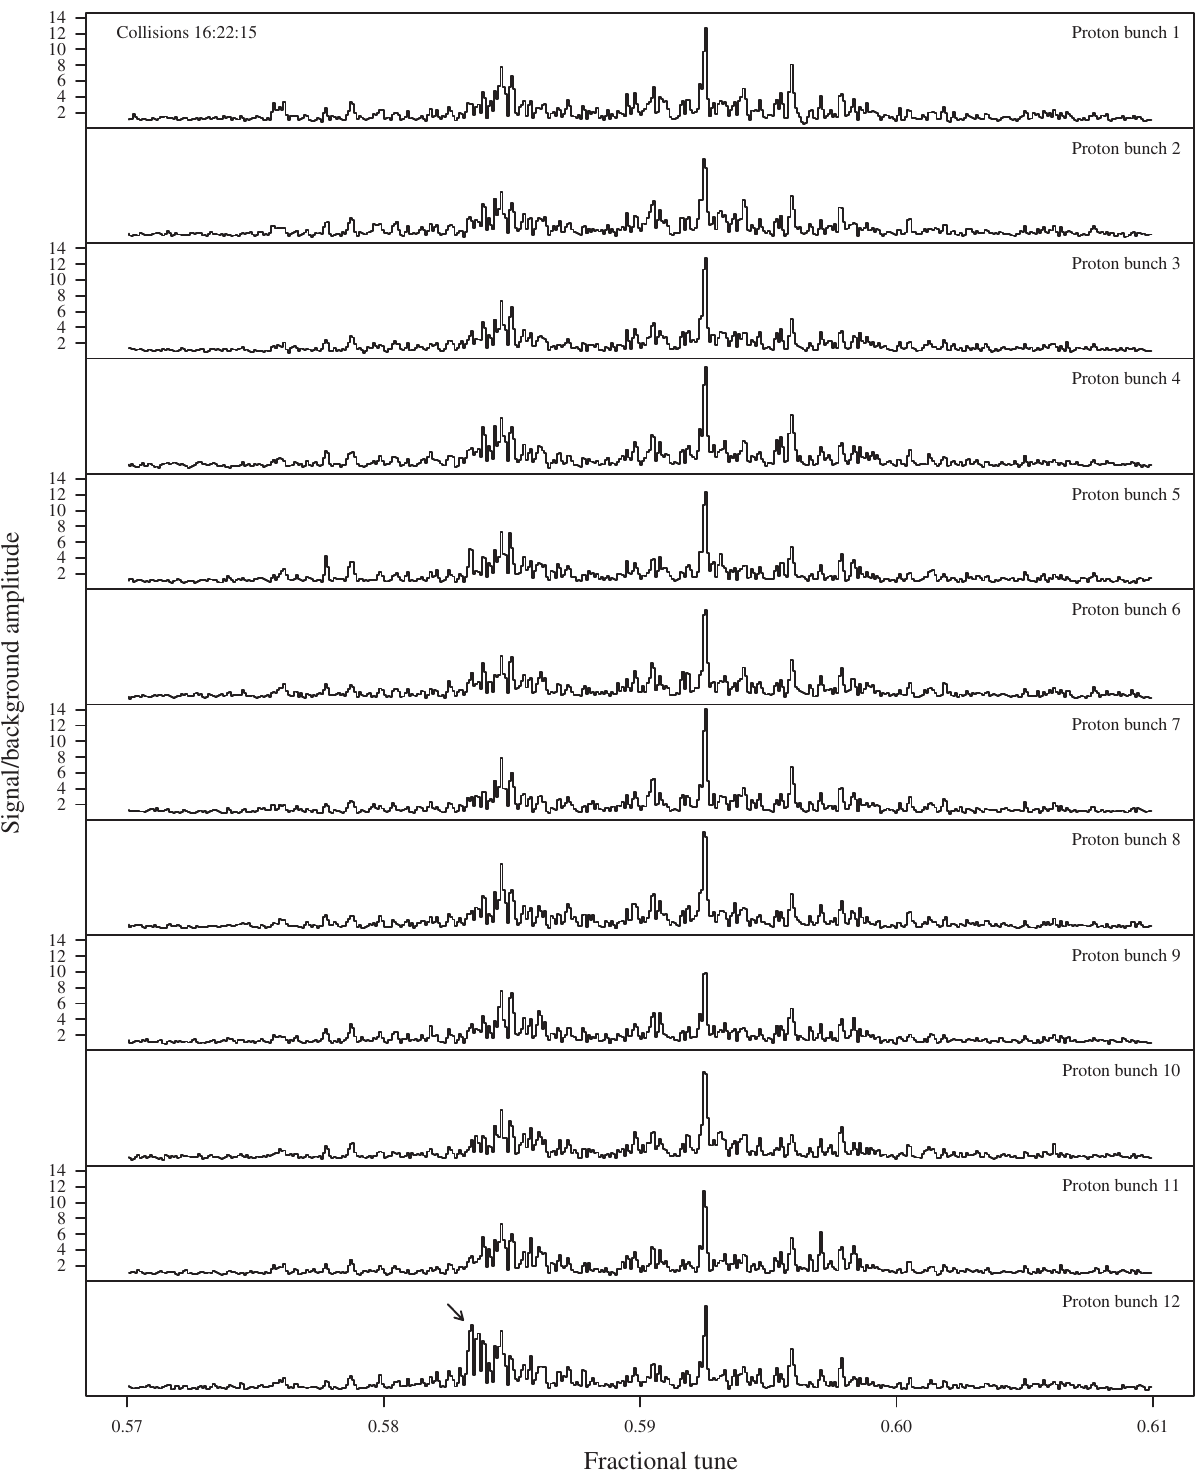
FIG. 10. Vertical coherent modes for all proton bunches in a train during Store